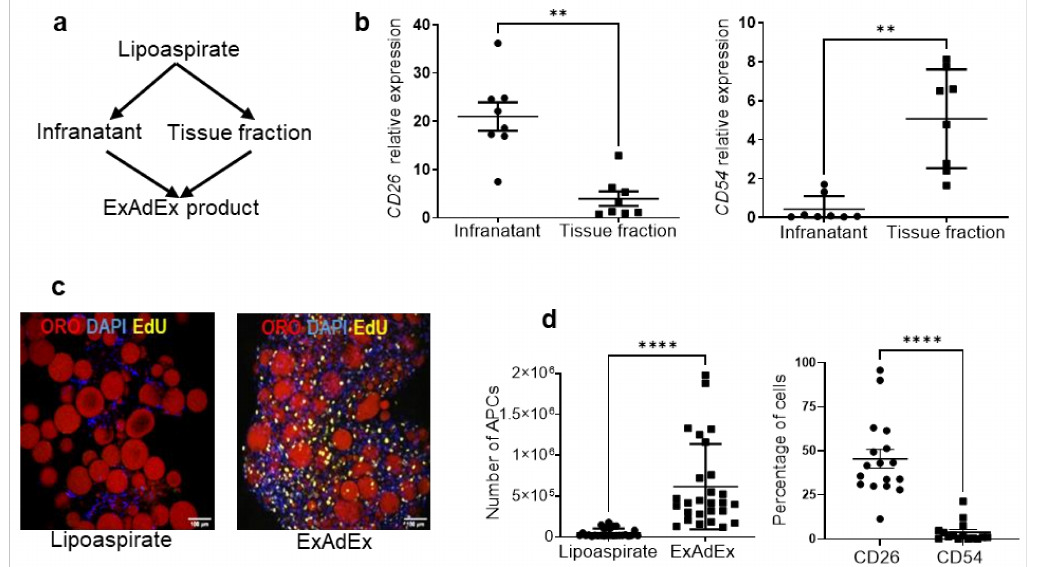
Figure 1. Generation of the ExAdEx model and its main characteristics. ( a ) A schema of the ExAdEx process. Cells were isolated from the infranatant of the lipoaspirates and then mixed with the tissue fraction previously dissociated mechanically. ( b ) CD26 and CD54 gene expression in the infranatant and the tissue fraction; n = 8 donors. ( c ) The ExAdEx process promotes cell proliferation. The lipoaspirate or the emulsified product after 14 days in culture was incubated with EdU for 24 h. Then the EdU click-iT-labeling of the EdU incorporated into cells was performed and confocal imaged. Red: ORO for lipid droplets; Yellow: Edu-labeled nuclei. Blue: DAPI for nuclei. Scale bar: 100 µ m. ( d ) Expansion of APC subpopulations. The number of total APCs was quantified from 100 mg of lipoaspirate and from the derived ExAdEx model maintained for 14 days in culture; n = 27 donors (left panel). Then, the percentage of CD26 + /CD54 − and CD54 + /CD26 − APCs was quantified by